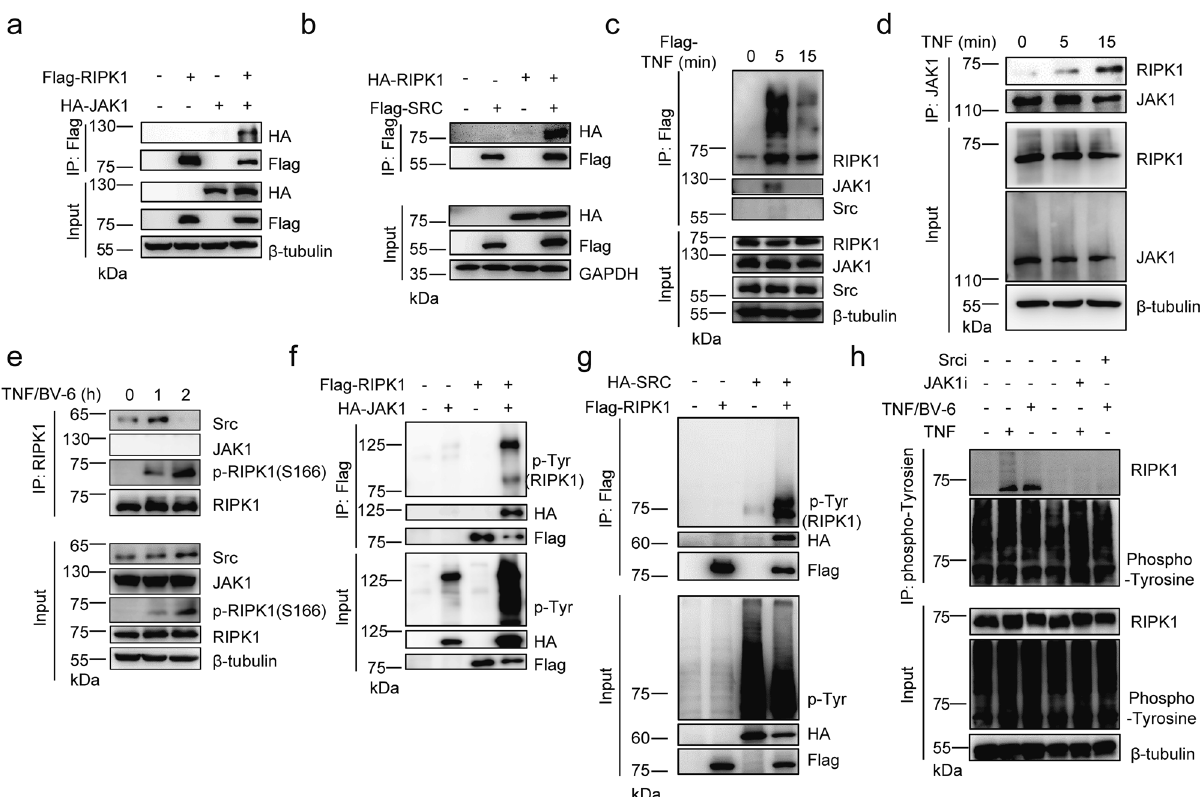
Fig. 1 | Identi fi cation of tyrosine phosphorylation as potential regulation of RIPK1 activity. HEK293T cells were co-transfected with expression vectors for Flag-RIPK1 and HA-JAK1( a ) or Flag-SRC andHA-RIPK1 ( b )for 24h. Celllysates were then immunoprecipitated with anti-Flag-Protein A/G agarose and analyzed by immunoblotting with the indicated antibodies. c Primary WT BMDMs were stimu- lated by Flag-TNF (100ng/ml) at indicated time points and TNF-RSC was immu- noprecipitated by anti-Flag resin for western blotting with indicated antibodies. Primary WT BMDMs were stimulated by TNF ( d ) or TNF/BV-6 ( e ) at indicated time points and whole-cell lysates were immunoprecipitated using anti-JAK1 ( d ) or anti-